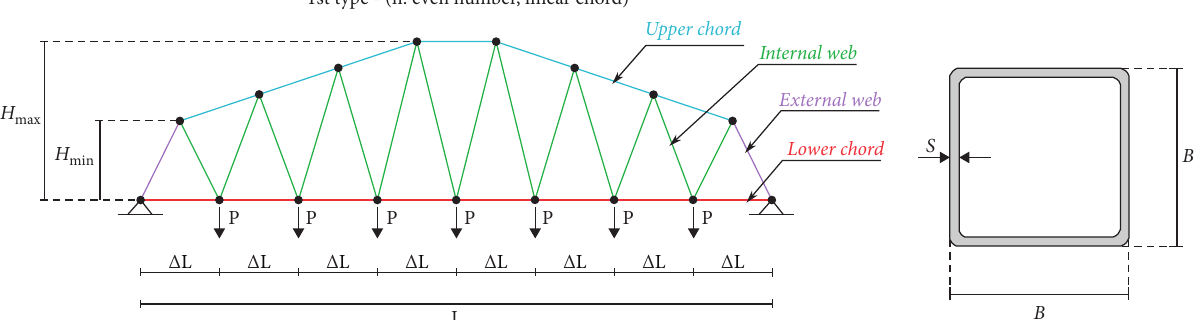
Figure 7: On the left, problem formulation of simply supported truss Warren beam. On the right, square hollow core tubular section with the indication of the design variables.